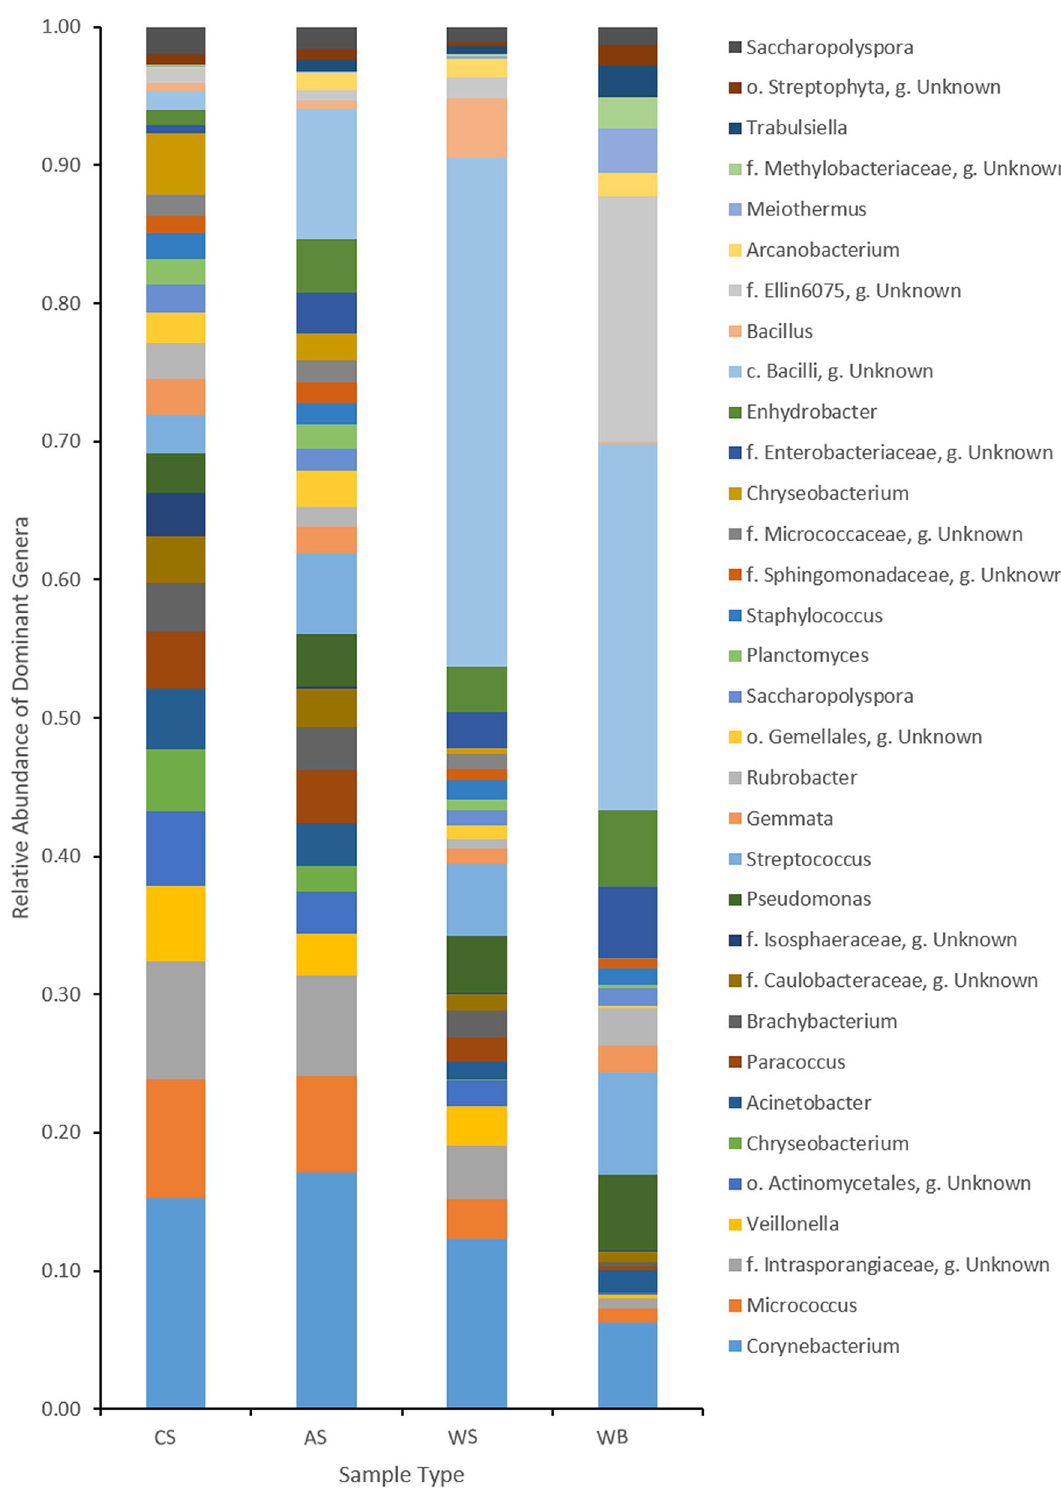
Figure 3. Stacked bar plots with dominant genera (relative abundance > 0.5%) in contralateral skin swabs (CS), adjacent skin swabs (AS), wound swabs (WS) and wound biopsies (WB). f: Family; o: Order; g: Genus. (Figure generated by Microsoft Excel